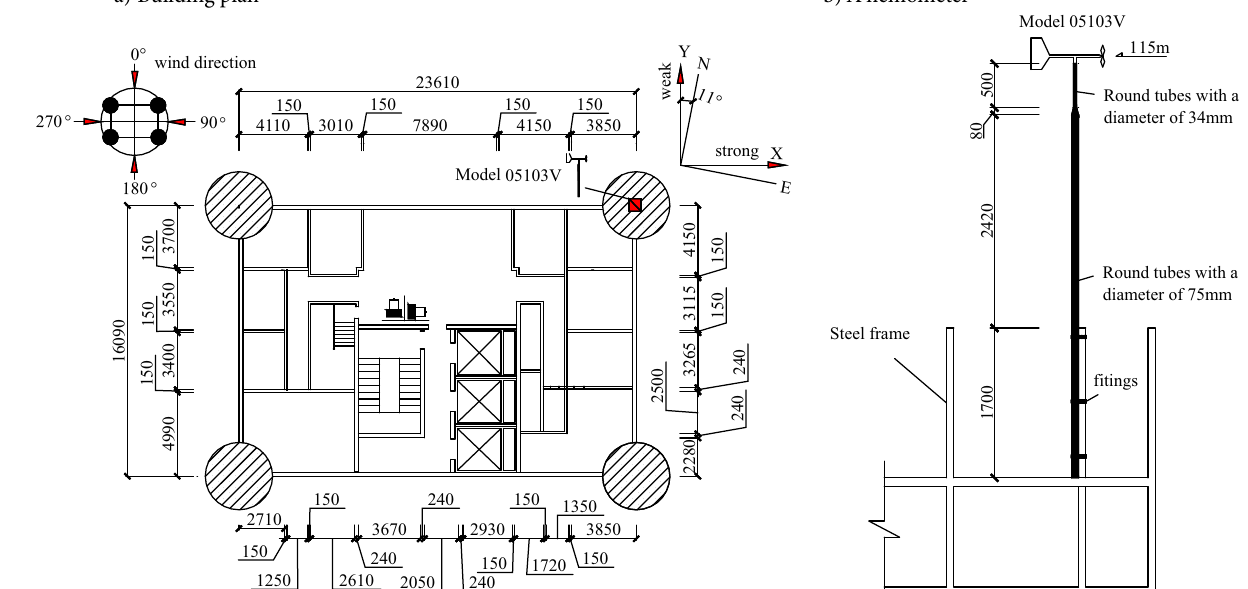
Figure 2. Distributions of anemometer atop the building and acceleration pickup devices on the top